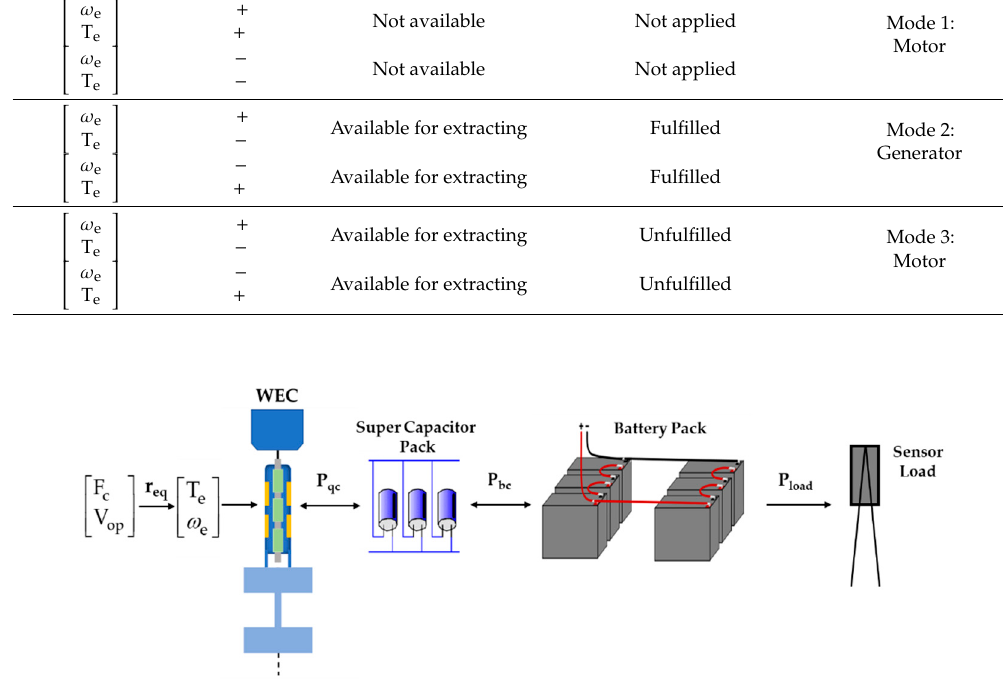
Figure 5. Power take-off and energy storage system electrical drive configuration.